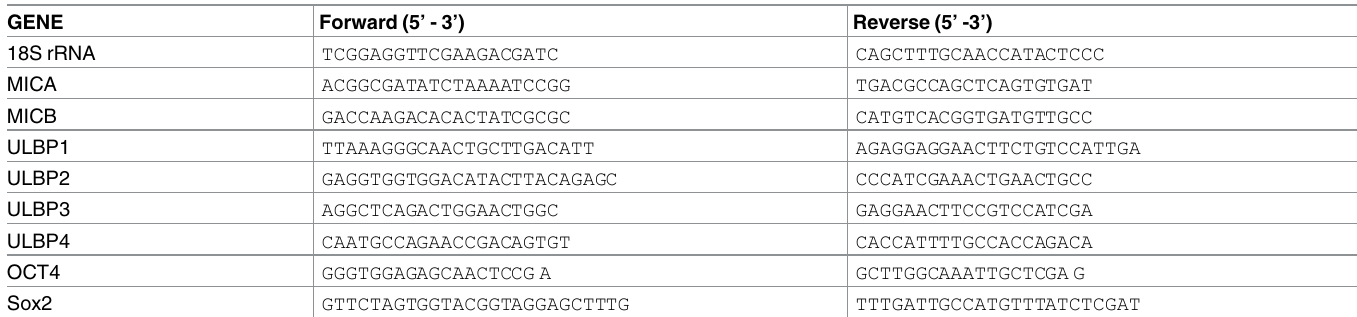
Table 1. PCR primer